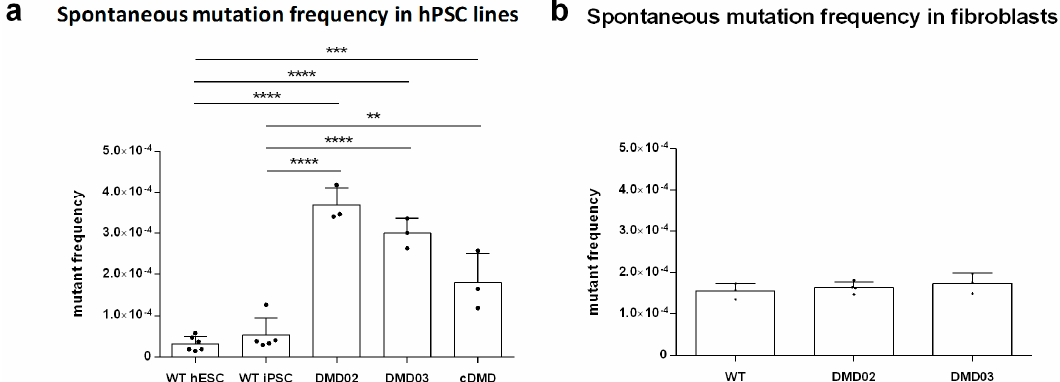
Figure 7. DMD hPSC lines present increased mutation frequency (MF). ( a ) MF of both patient specific hiPSC lines (DMD02 and DMD03), cDMD line and WT hESC and hiPSC line were measured using HPRT reporter assay. The graph shows significantly elevated spontaneous MF in all DMD hPSC lines compared to both WT hPSC lines. ( b ) The parental patient specific fibroblasts (DMD02 and DMD03) were compared to WT human foreskin fibroblasts of similar passage to exclude artificial effect of present MF before the reprogramming. No statistical difference was found in between all analyzed fibroblast lines. Statistical difference was evaluated by one-way ANOVA and Sidak’s multiple comparison test (* p < 0.05, ** p < 0.01, *** p < 0.001, **** p < 0.0001). The error bars represent standard